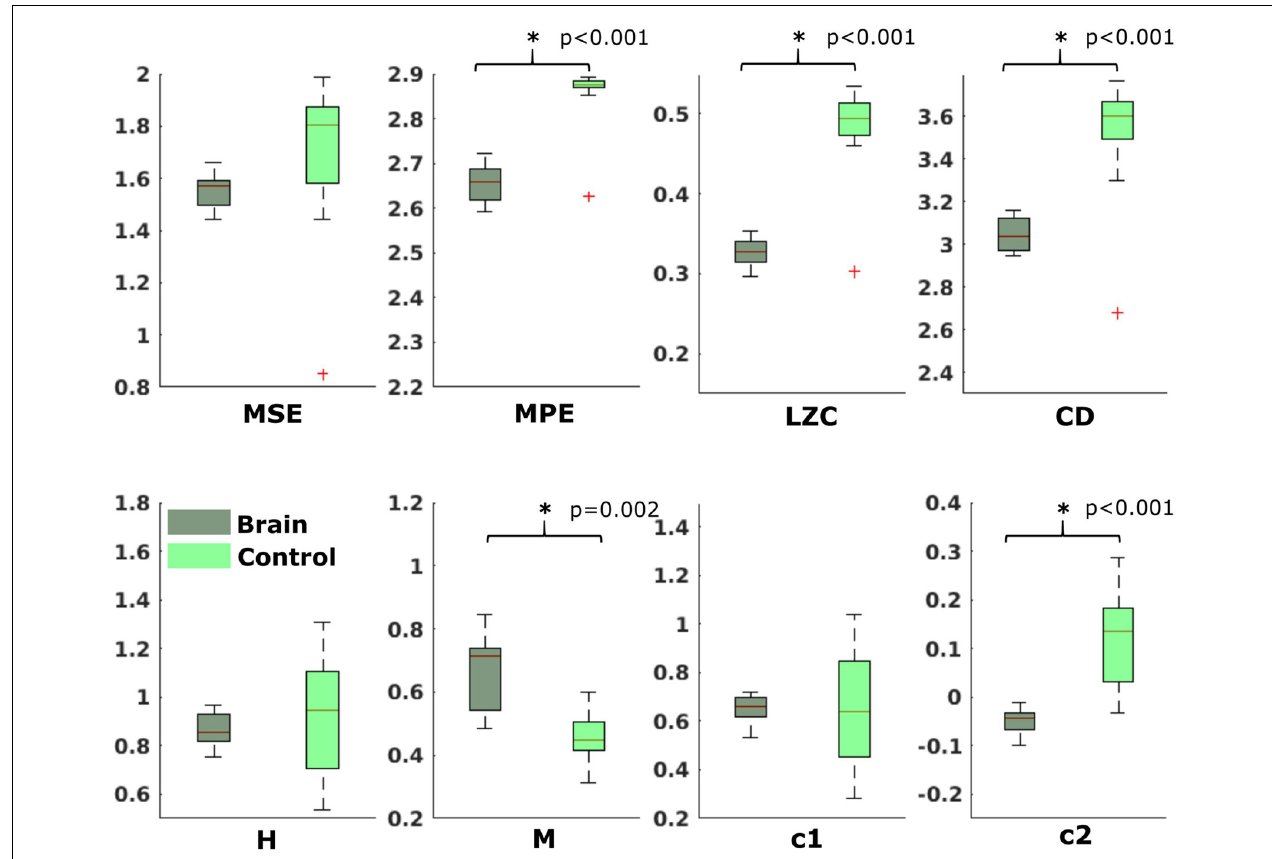
FIGURE 6 | Results from analysis of different metrics on data from neonates with auditory stimulation. ∗ Depicts significant difference ( p = 0.006).